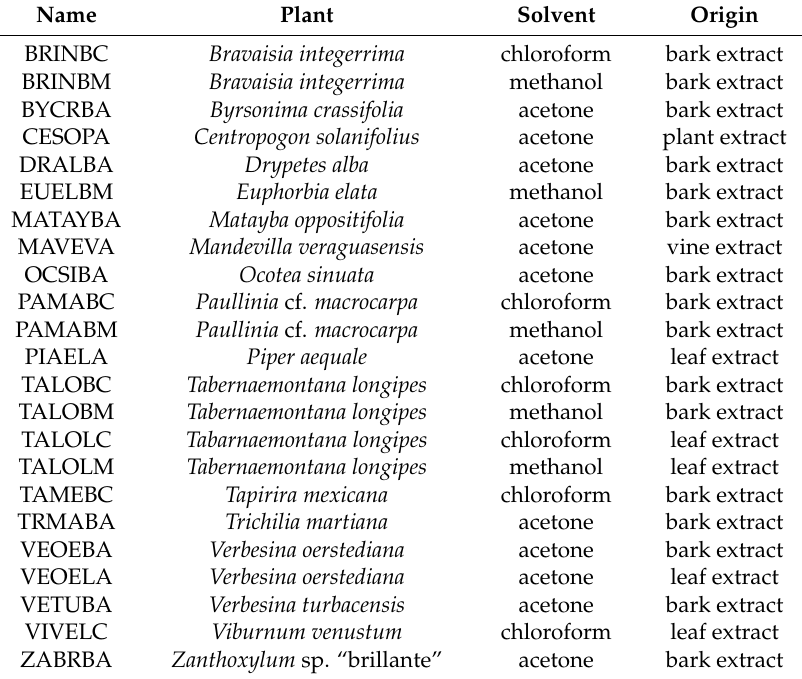
Table 1. Plant extracts tested for the ability to boost the antimicrobial activity of human blood against Staphylococcus (S.)